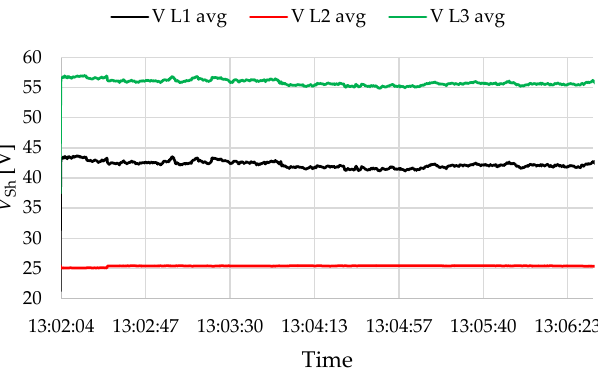
Figure 19. Sheaths currents measured in Substation 2. Sheaths cross-bonded according to: L1 → L3, L2 → L2, L3 → L1 (Sh5). Operation only with the analyzed line.